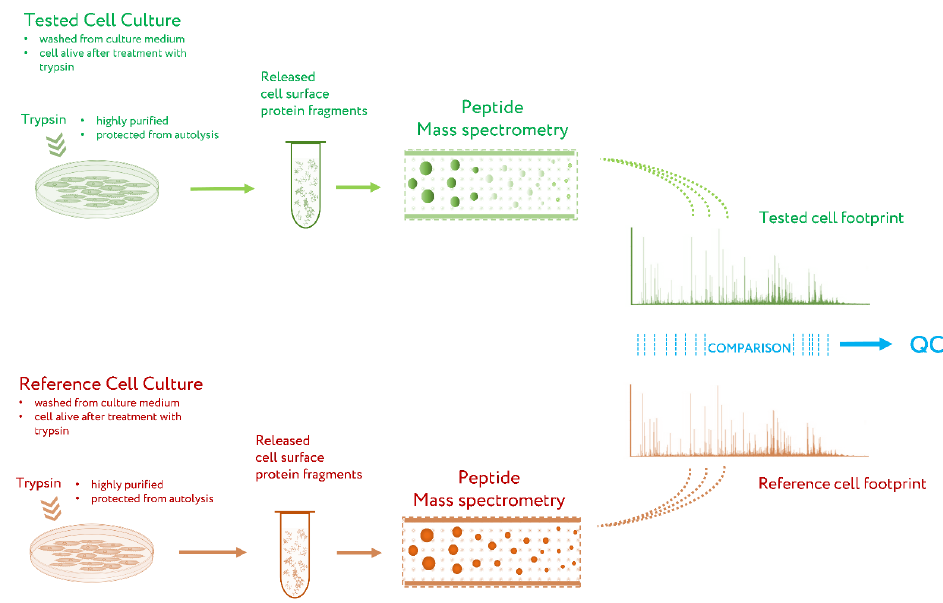
Figure 2. Workflow of cell proteomic footprinting. QC, quality control. Adapted from [47].